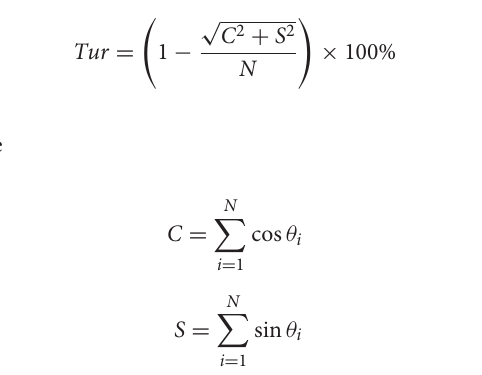
to low are expressed by colors from red to orange, to yellow, and to green ( Figure 2 ). Tur indices were calculated by the ultrasound